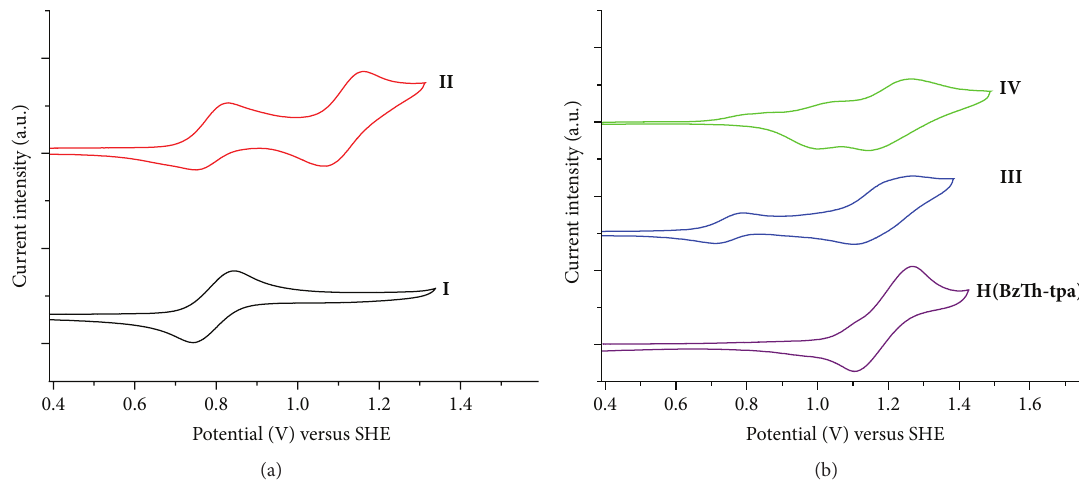
Figure 2: Cyclic voltammograms of (a) complexes I - II and (b) ligand H ( BzTh-tpa ) and complexes III - IV . Scan rate 100mVs −1 in dry dichloromethane.